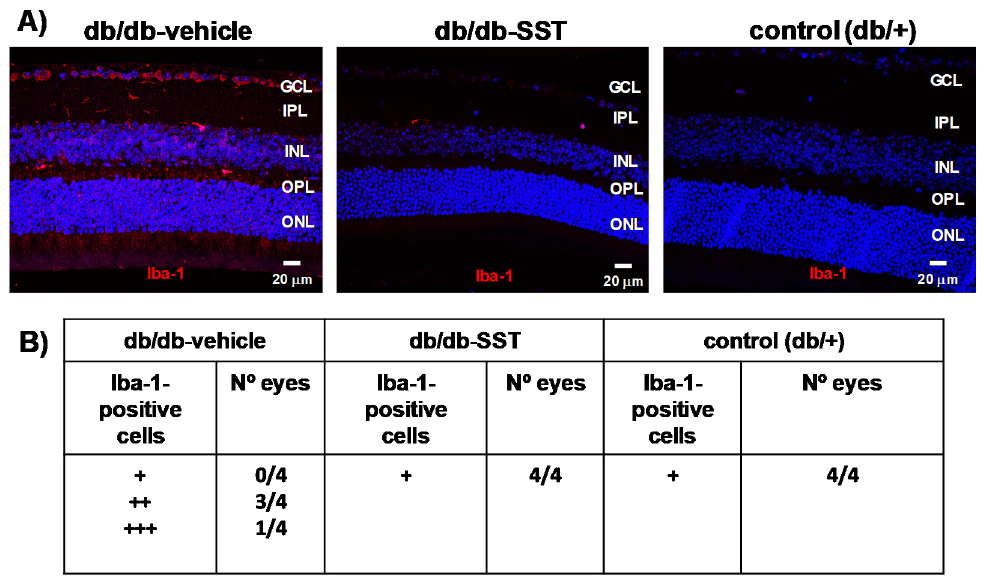
Figure 2. Effect of topical SST administration on microglia activation in db/db mice. ( A ) Representative immunofluorescence of Iba-1 (red) in representative mice from each group. Scale bars, 20 µm. ( B ) Semiquantitative assessment of microglial activation in the retina [-: absence of positive cells for Iba-1/power field (20×); +: scattered, 1–3 cell/power field (20×); ++: moderate, 4–10 cells/ power field (20×)]. N: 10 mice per group.